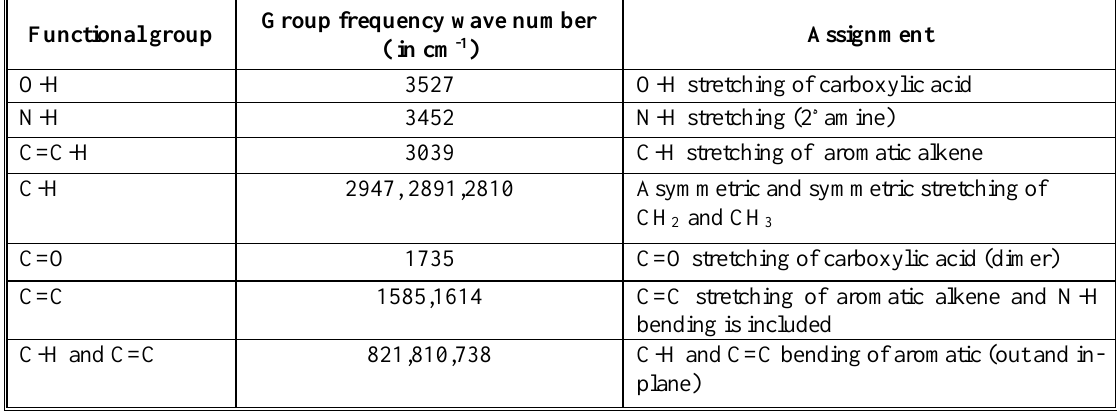
Table 5. The characteristic bands frequencies from FT-IR spectrum of isolated (30) Functional